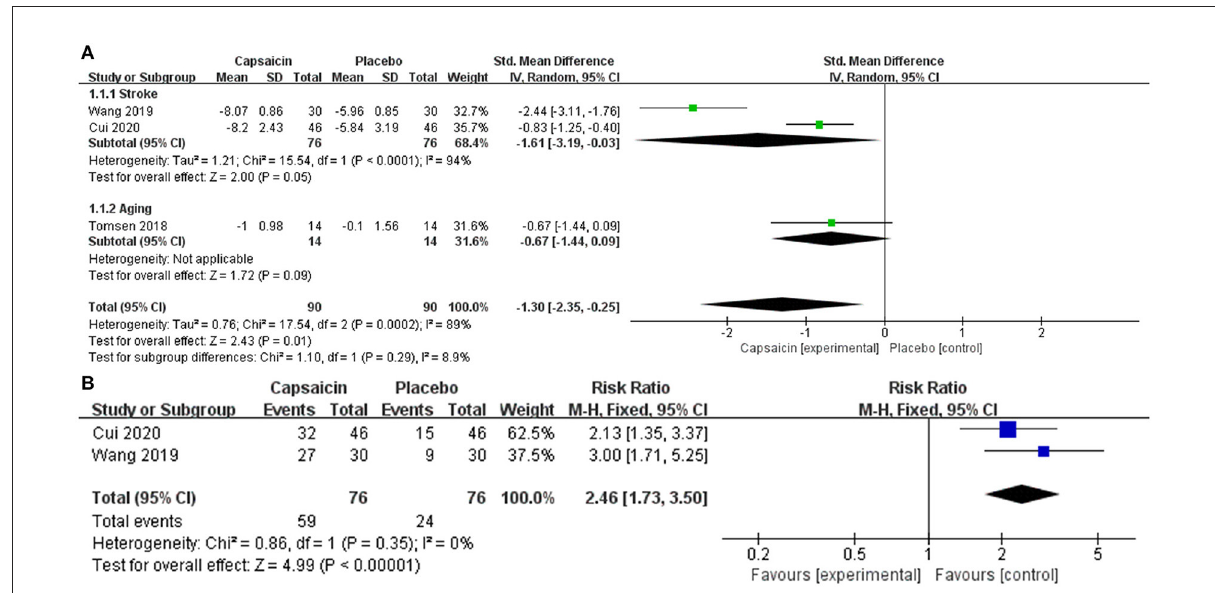
FIGURE4 Forest plot demonstrates the effectiveness of capsaicin for oropharyngeal dysphagia: (A) swallowing function, (B) water swallowing test.